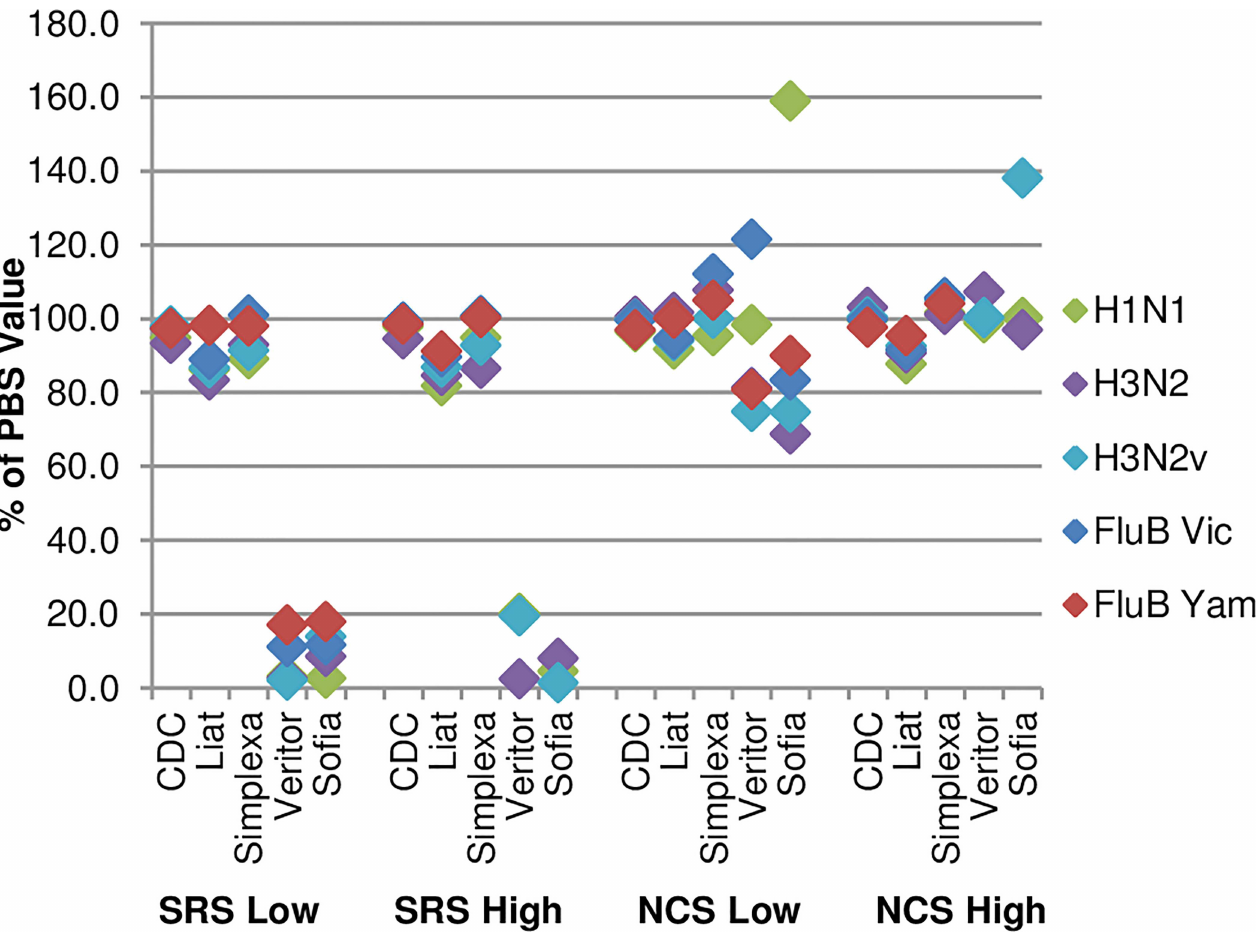
Fig 2. Results of testing virus spiked in PBS, SRS, and NCS with six assays. Ct and antigenassay signal results were normalized as a percentage of the PBS result value. Data for high and low concentrations of virus are shown.